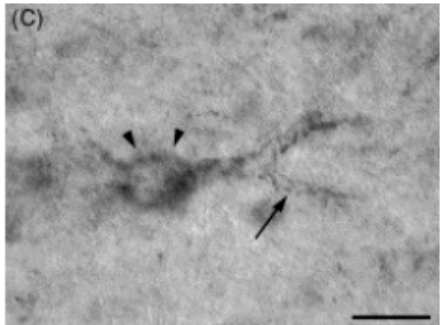
Figure 4. Aged cat’s brain. Individual neurons show an accumulation of A β 1–42 (labeled with anti-A β 1–42), both in apical dendrites (arrows) and within the somatodendritic compartment (arrowhead). Bar = 20 μ m. Reprinted from Neurobiology of Aging , 26, Head E., Moffat K., Das P., Sarsoza F., Poon W.W., Landsberg G., Cotman C.W., Murphy M.P. β -Amyloid deposition and tau phosphorylation in clinically characterized aged cats., 749–763, 2005, with permission from Elsevier [70].